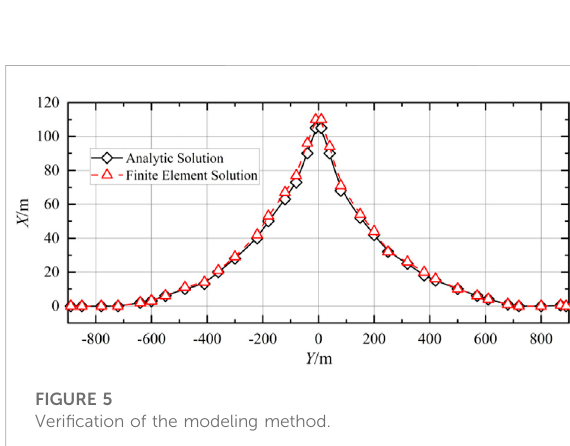
FIGURE 4 Multi-point horizontal lifting model.